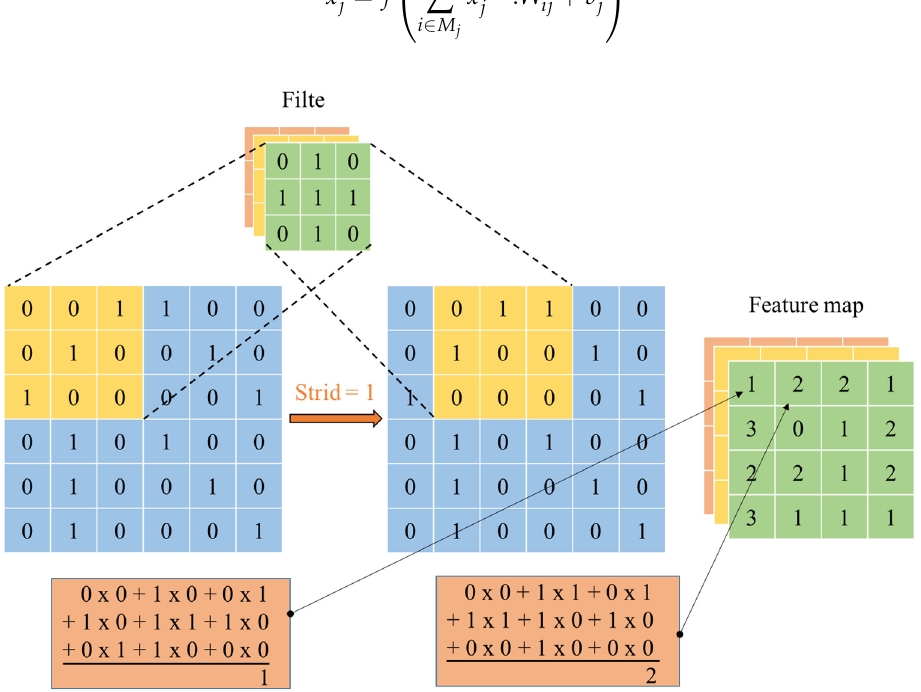
Figure 13. The operational method of the convolution layer .